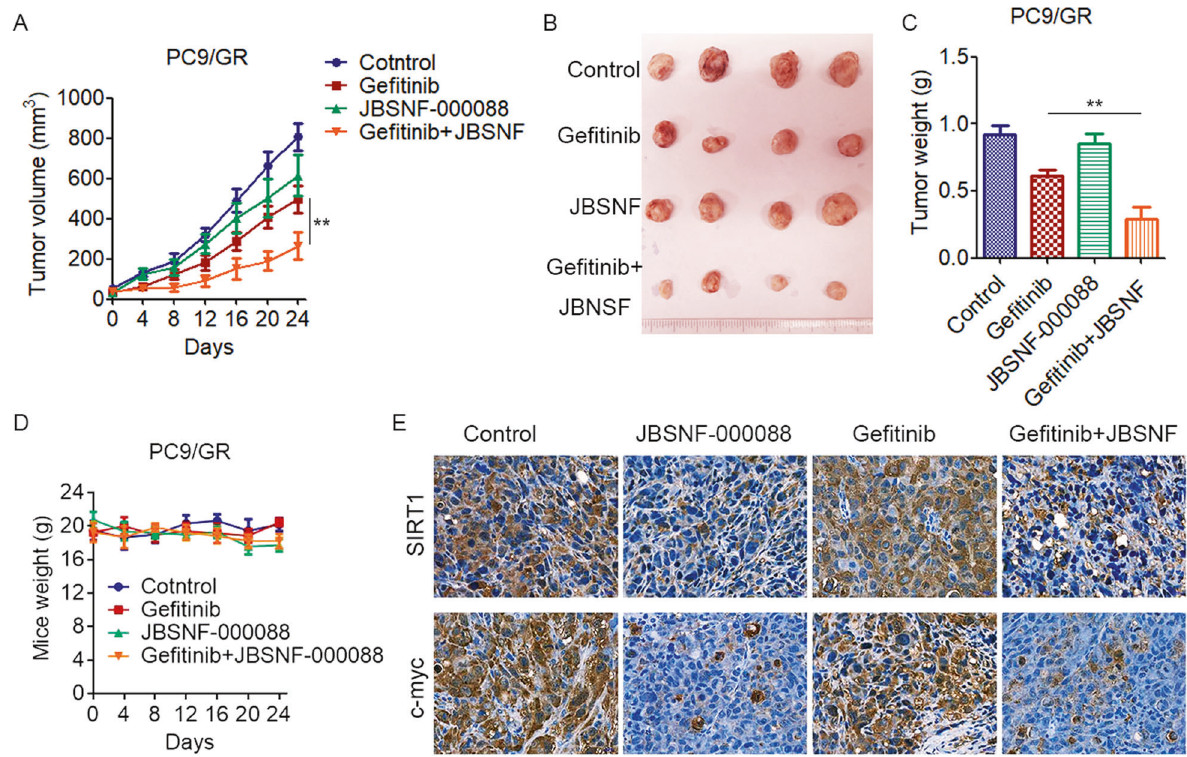
Fig. 7 Pharmacological inhibition of NNMT overcomes EGFR-TKIs resistance in NSCLC cells in vivo. A – C 5 × 10 6 PC9/GR cells were subcutaneously injected into nude mice and palpable tumors were allowed to develop for 7 days. Mice were randomly divided into four groups and treated with vehicle control (0.01% DMSO in PBS), ge fi tinib (50 mg/kg/d), JBSNF-000088 (50 mg/kg/d), or a combination of ge fi tinib with JBSNF-000088 every other day ( n = 4, per group), A The tumor size was measured at indicated time intervals and calculated. The tumor volume was calculated using the formula: V = 1/2 × larger diameter × (smaller diameter) 2 , and growth curves were plotted using average tumor volume within each experimental group at the set time points, B At the end of treatment, tumors were excised, C Tumor weights were measured. D Treatment of ge fi tinib or/and JBSNF-000088 has no effect on mouse body weight. E PC9/GR xenograft tissues derived from mice were fi xed, sectioned, and placed on slides. Tumor specimens were subjected to immunohistochemical staining with antibodies speci fi c to SIRT and c-myc. (** p <